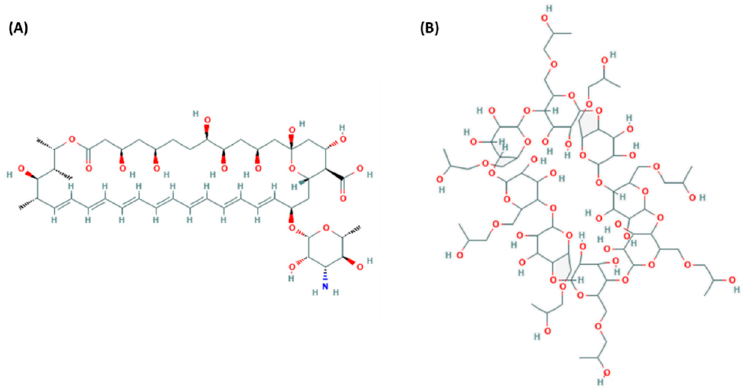
Figure 1. Chemical structure of amphotericin B ( A ) and 2-hydroxypropyl- γ -cyclodextrin ( B ). Publically available from [29].